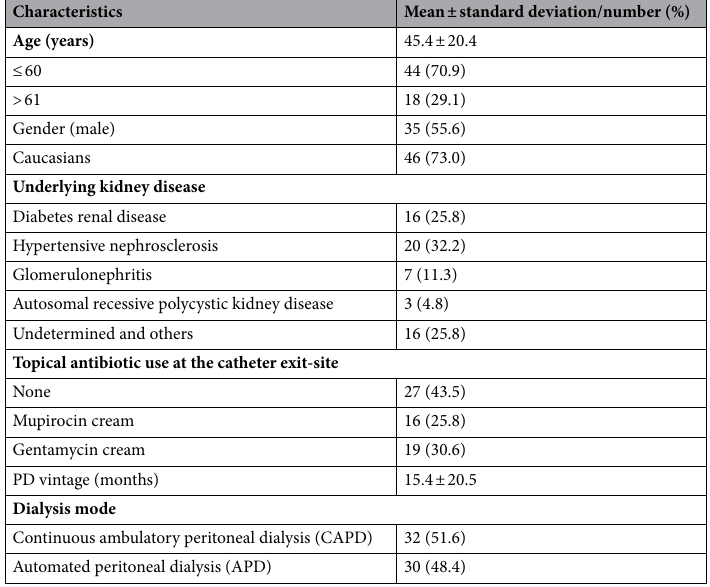
Table 1. Characteristics of 62 patients the time of the 1st episode of nonfermenting Gram-negative bacilli peritonitis.